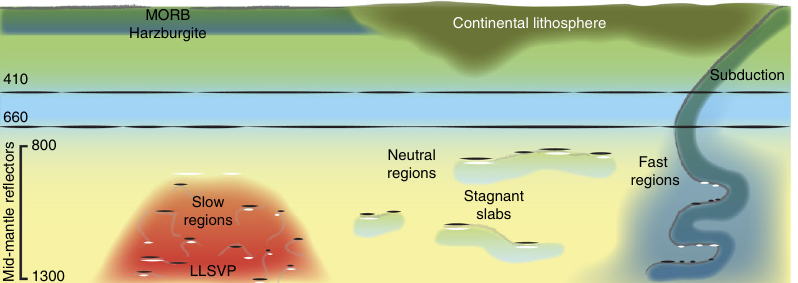
Fig. 9 Conceptual interpretation of our observations of three distinct mantle domains. Potential sub-horizontal mid-mantle re fl ectors are denoted black (positive impedance) and white (negative impedance) and grouped by seismic domains: (1) Fast, cold downwelling regions (blue), with heterogeneities that are predominantly too small and variable to be resolved by SS precursors (major example region: Eastern Europe). (2) Slow, hot upwelling regions (red) (major example region: South-central Paci fi c). (3) Neutral regions (yellow), perhaps with compositionally or texturally distinct material (lighter yellow). Slabs may stagnate above these features, generating shallow re fl ections for the neutral domains (major example region: northern Paci fi c). Basaltic heterogeneity is denoted by black contours, with grey lines indicating heterogeneities that do not necessarily correspond to re fl ectors. Other known global re fl ectors in the mantle are indicated by black lines; e.g., at the 410 and 660 km